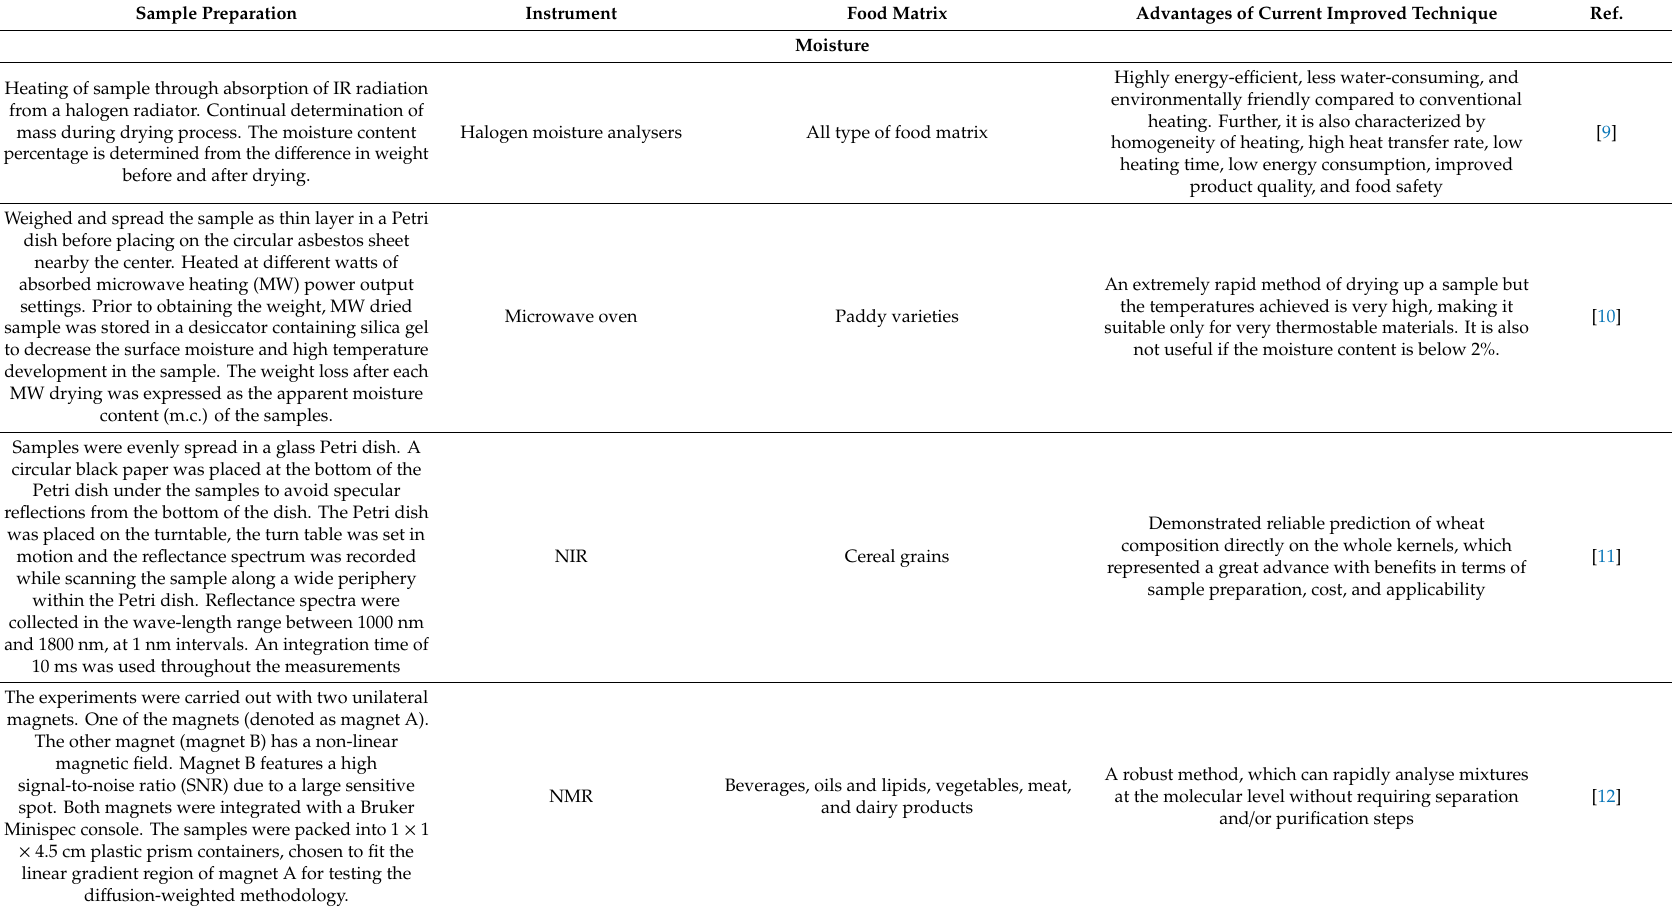
Table 1. Methods, food matrices and advantages of current improved technique for